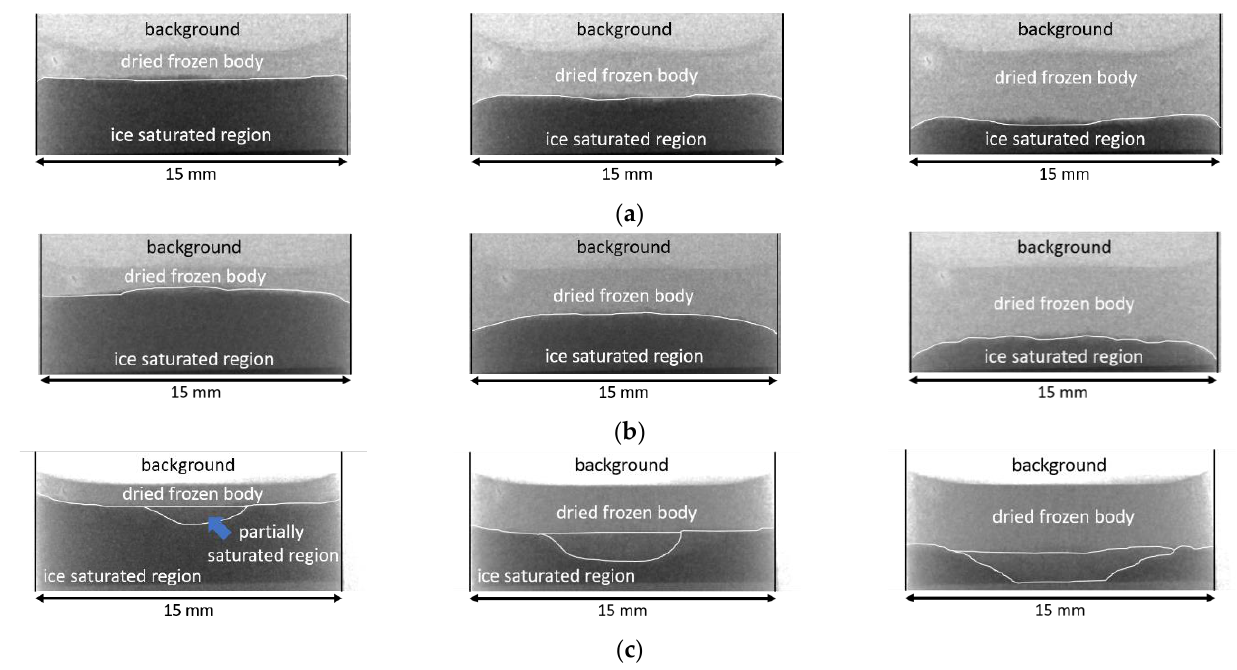
Figure 5. Evidence of structured sublimation fronts from radiographic images taken at ice saturations of S = 0.25, 0.5 and 0.75: ( a ) MD5, ( b ) MD5 AN and ( c ) MD30. In partially saturated regions the overlap of the dried and ice-filled regions results in saturation values between 1 and 0.